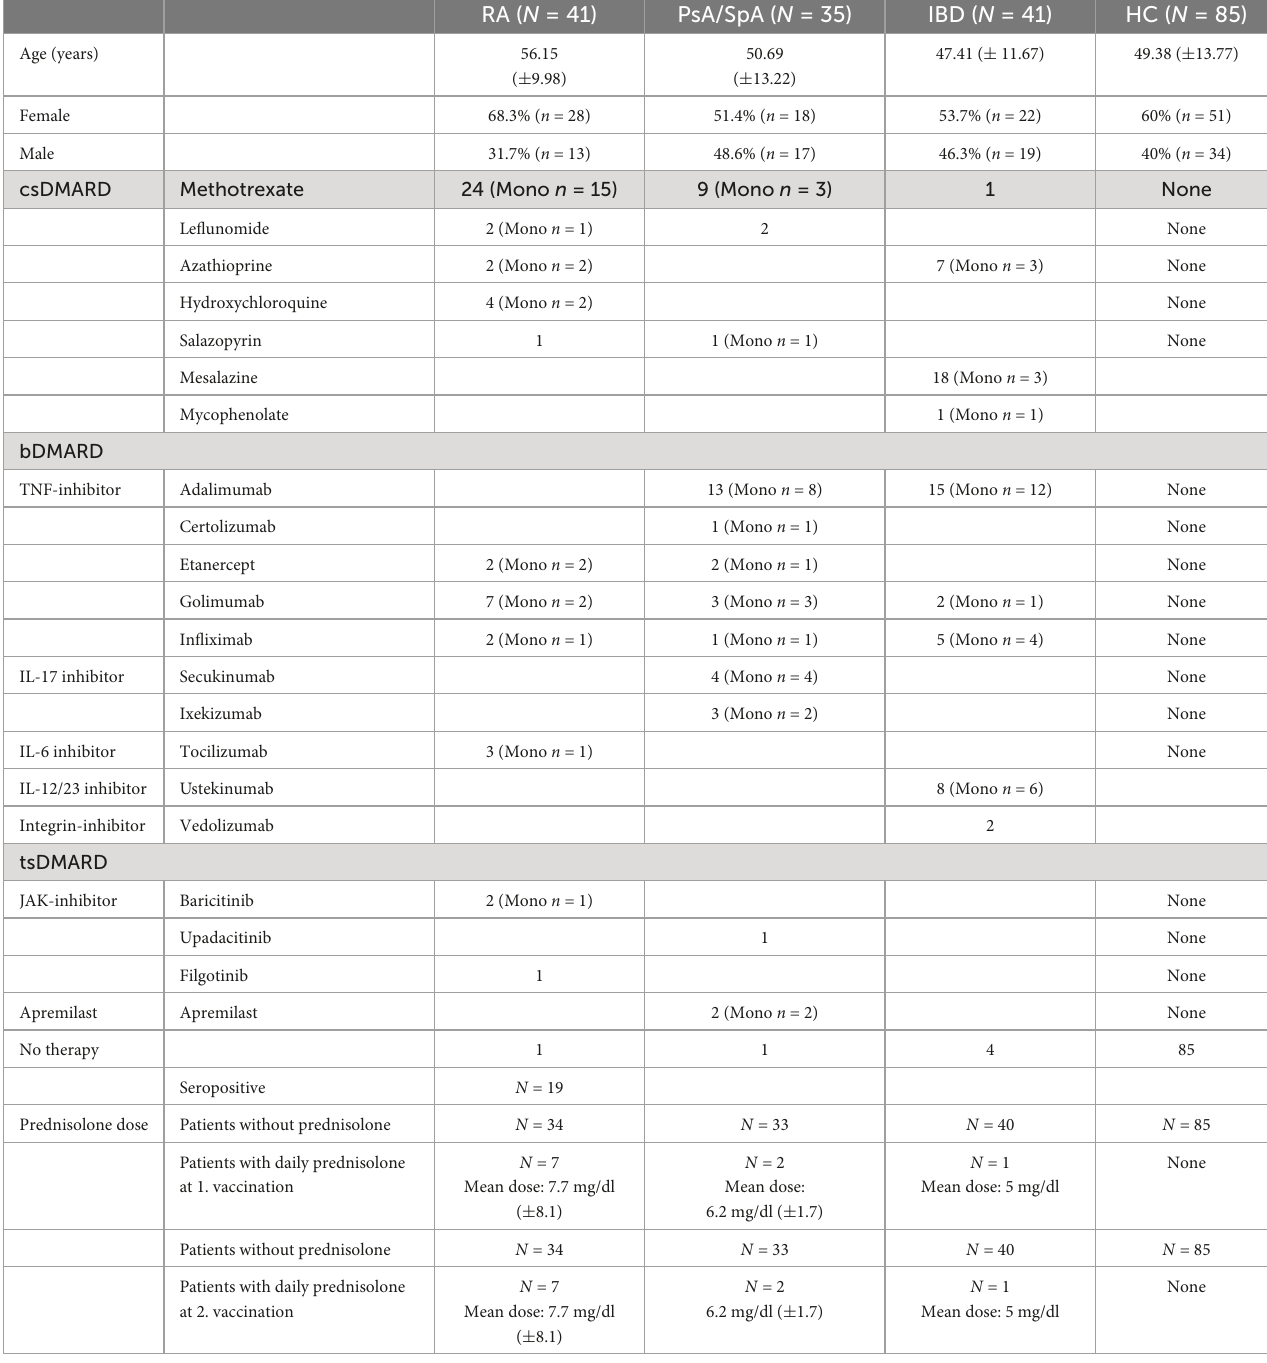
TABLE 1 Characteristics of patients and